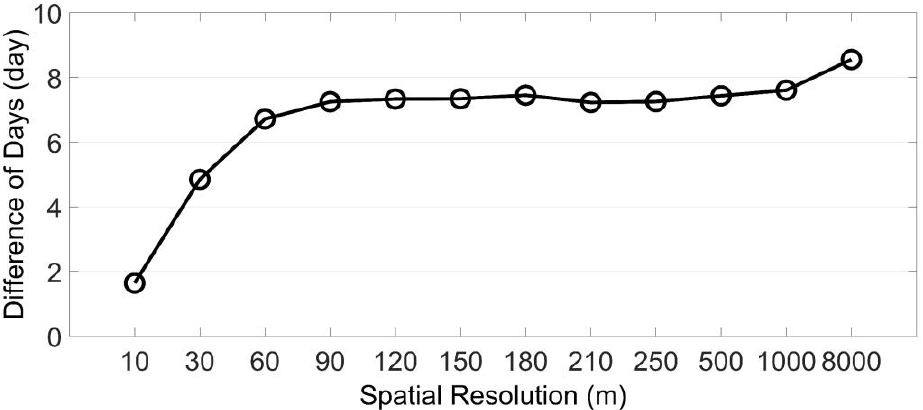
ff erences of vegetation spring phenology from 10 m to 8 Figure 9. Rural – urban differences of vegetation spring phenology from 10 m to 8 km. Figure 9. Rural–urban di